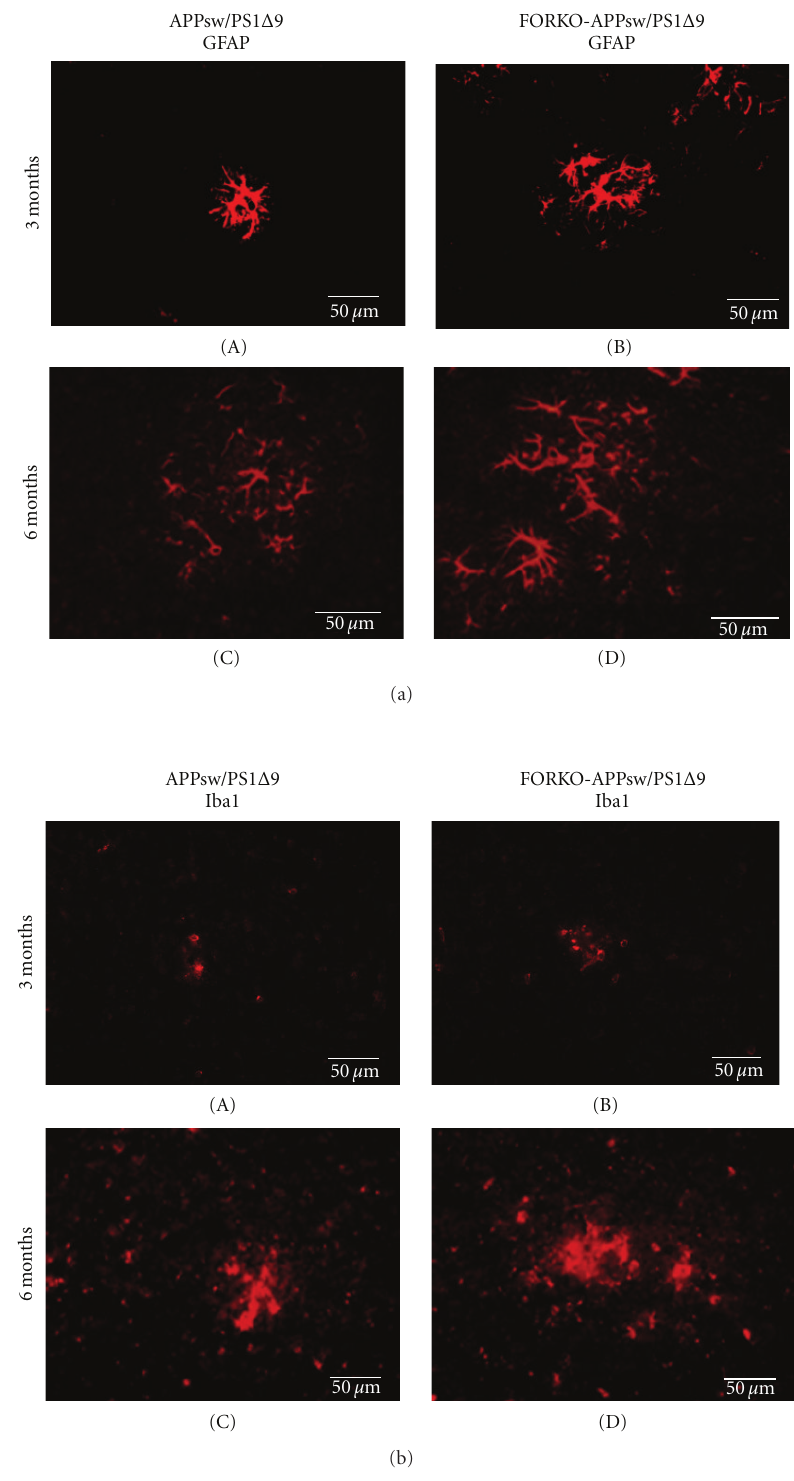
Figure 3: Sex-hormone-imbalanced 6-month-old FORKO-APPsw/PS1 microglia in the vicinity of plaques in the hippocampus. Immunostaining for astrocytes and microglia was performed in representative areas of the cortex using polyclonal antibodies for GFAP (a) and MacII in (b) in APPsw/PS1 astroglia and microglia show an enlargement and increase in number, suggesting glial activation and inflammation in both APPsw/PS1 9 mice, more strikingly in the latter model. Scale bar measures 50 μ FORKO-APPsw/PS1 (cid:0)